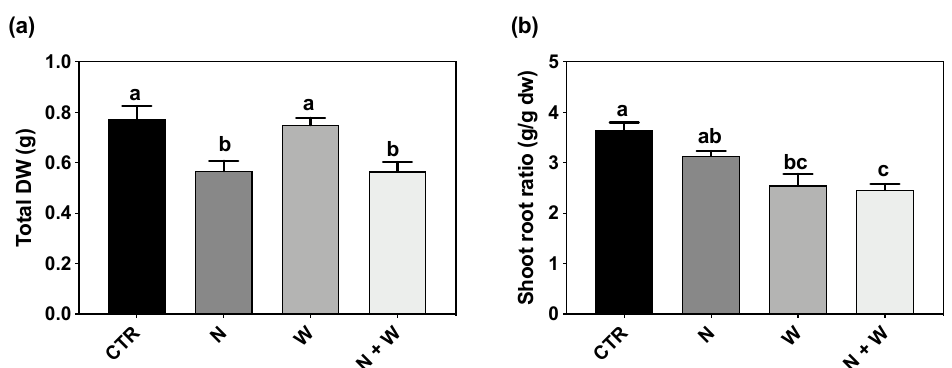
Figure 1. Total dry weight ( a ) and shoot–root ratio ( b ) of tomato plants cv. Mico-Tom grown for 16 days under control (CTR; 10.5 mM N + 100% W), nitrogen deficit (N; 5.3 mM N + 100%W), water deficit (W; 10.5 mM N + 50% W) or combined nitrogen and water deficit (N + W; 5.3 mM N + 50% W). Data presented are mean ± SEM ( n = 6). Different letters above bars indicate significant differences according to the Tukey’s HSD test ( p = 0.05).